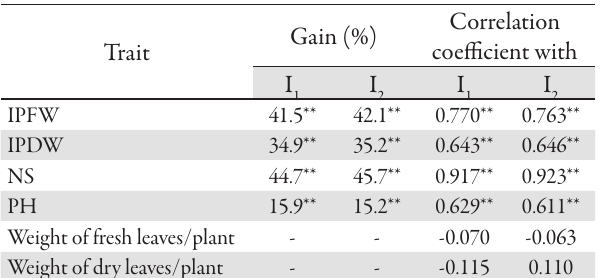
Tab. 2. Coefficient of correlation of traits in adult plant stage with I and I and percentage increase of the traits when 1 2 selecting the top 10% of plant for I population mean.